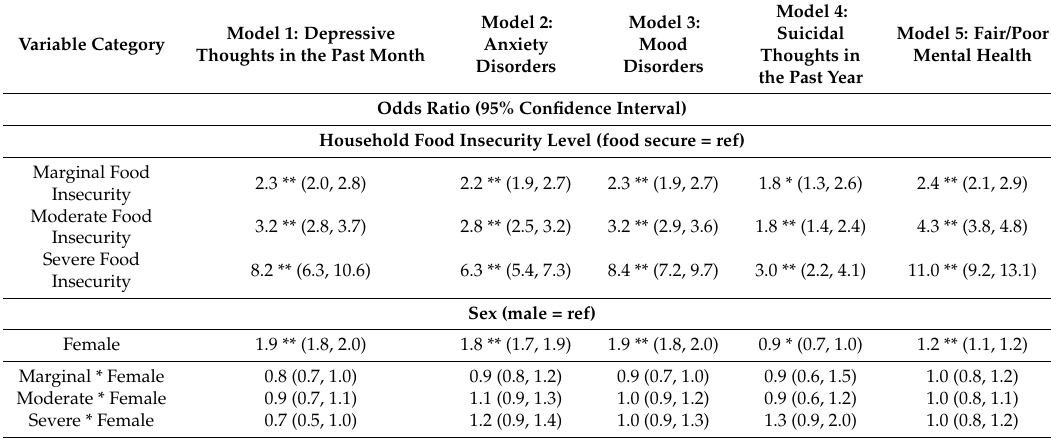
Table 3. Sex-adjusted binary logistic regression models of household food insecurity and five adverse mental health outcomes, including food insecurity and sex interactions.